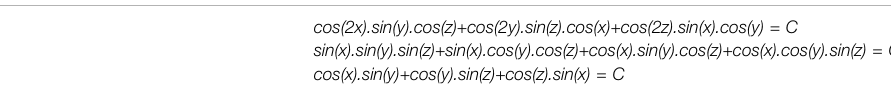
TABLE 1 | Equations for three TPMS architectures. TPMS structures Equations for TPMS: f (x, y, z) = C Fischer – Koch S